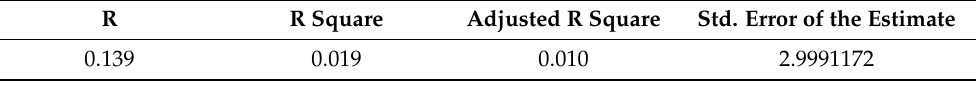
Figure 4. Economic growth, openness, size and risk diversification of the stock market From Figure 4, one can draw some visible patterns of the growth-dependent parameter, in correlation with size and openness, while the regression results show a